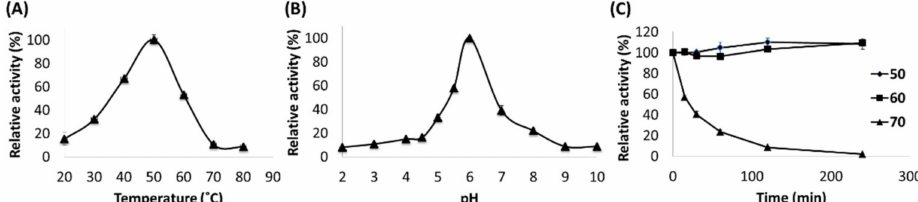
Figure 3. Effect of pH and temperature on enzymatic activity. Effect of temperature ( A ) and pH ( B ) on enzymatic activity of Mt GLOx. Values calculated as a percentage of the activity at the maximum. ( C ) The enzyme residual activity after incubation at different temperature is represented as a percentage with respect to the enzyme initial activity at different incubation